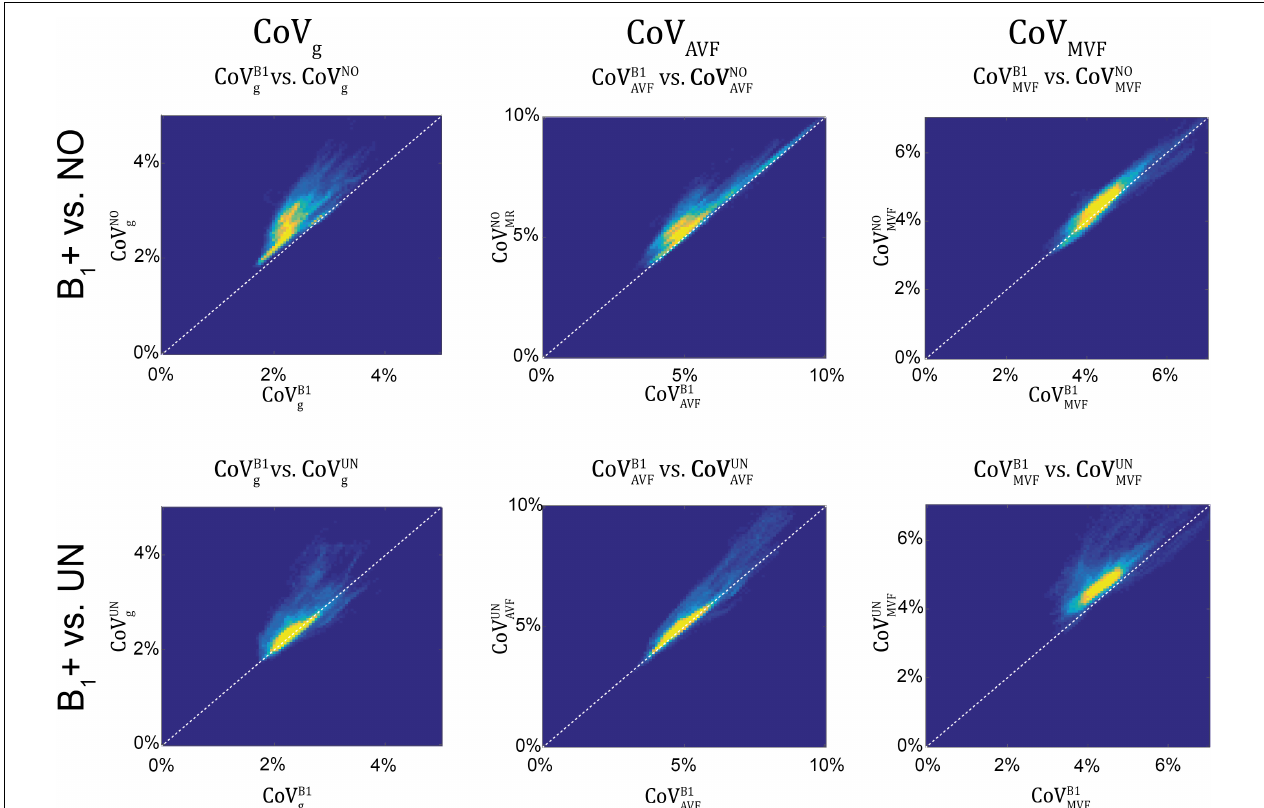
FIGURE 12 | Scatter density plots of CoV g (left column), CoV AVF (middle column), and CoV MVF (right column), plotting values obtained with no correction (superscript: NO, top row) and with UNICORT B 1 + correction (UN, bottom row) against values obtained by B 1 + field map correction (superscript: B1). The unit slope line is plotted for orientation (dotted line). The dots in the scatter plots represent the WM voxels in the CoV maps in Figure 10 (yellow indicates high voxel